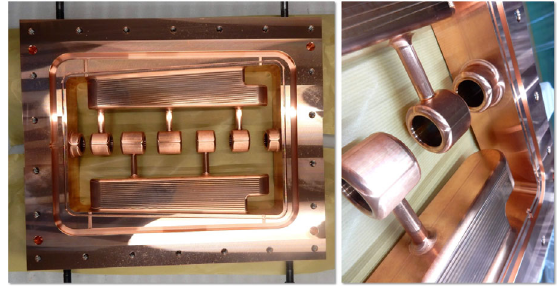
FIG. 6. Fabricated center plate of the short IH.